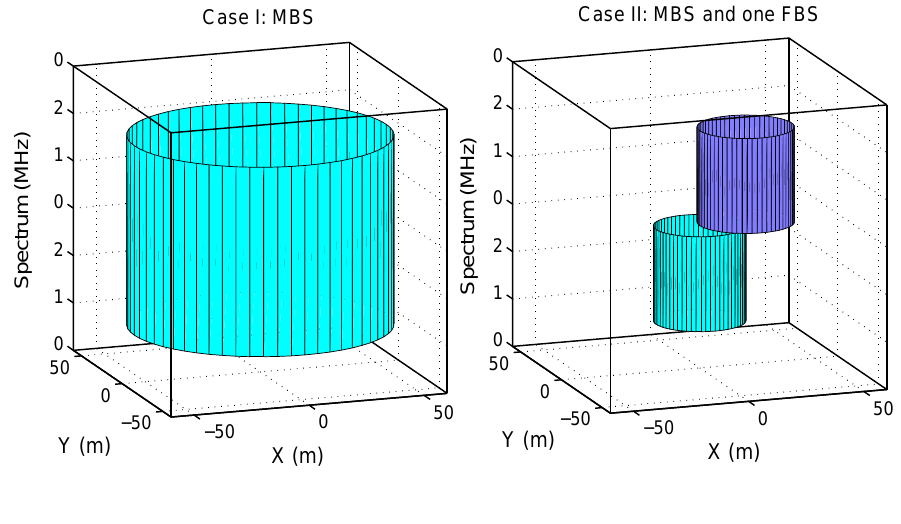
Figure 4. Case I vs. Case II: interference footprints.